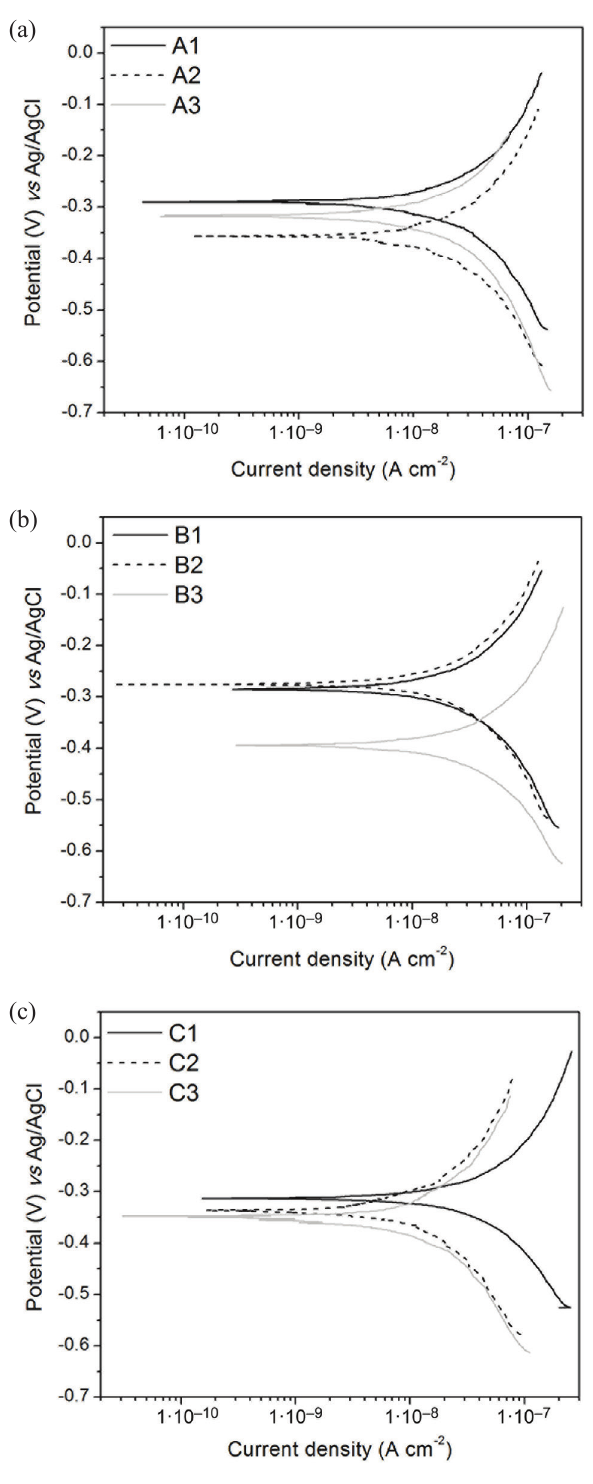
Fig. 4 – Polarization curves for 1020 carbon steel in com- mercial gasoline from automotive fuel retail brands A (a), B (b), and C (c)